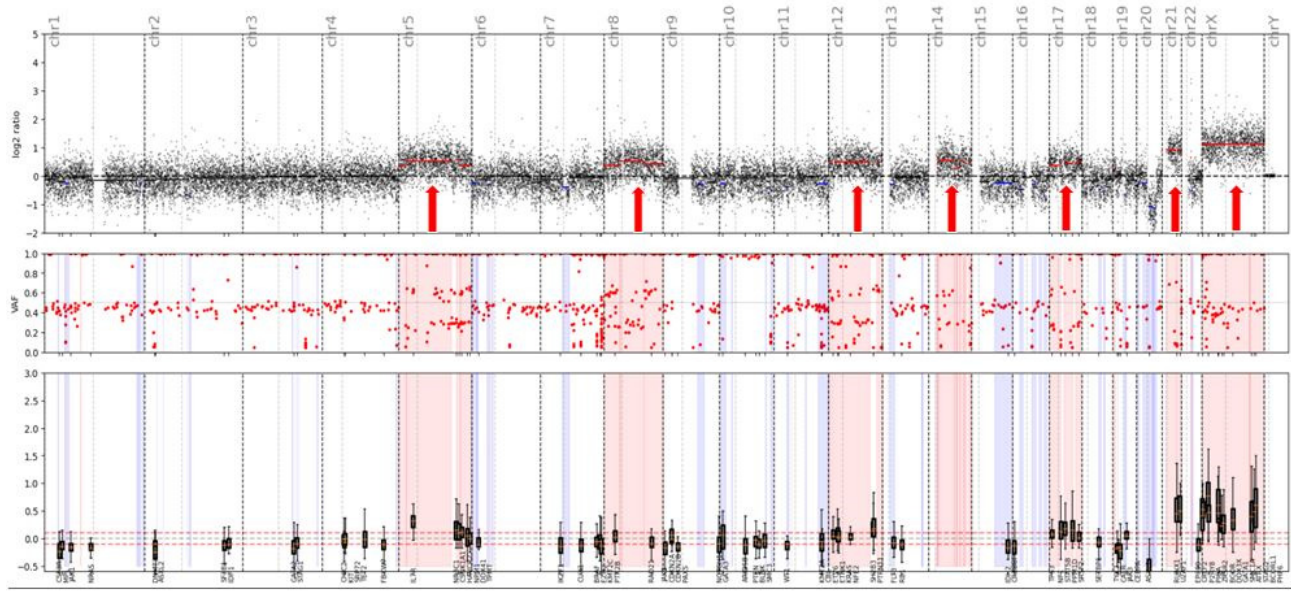
Figure 3. CNV plot—Patient number 12; B-ALL. CNV plot obtained is consistent with hyperdiploid karyotype: 53, XXY: +5, +8, +12, +14, +17, +21, +X. Several focal chromosomal deletions are also observed in this sample.